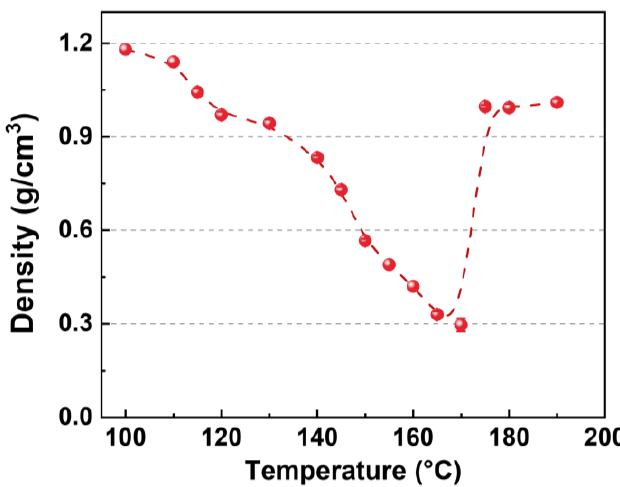
Figure 4. Density of HD-TPU foams as a function of saturation temperature. The saturation pressure and time were 18 MPa and 30 min, respectively.